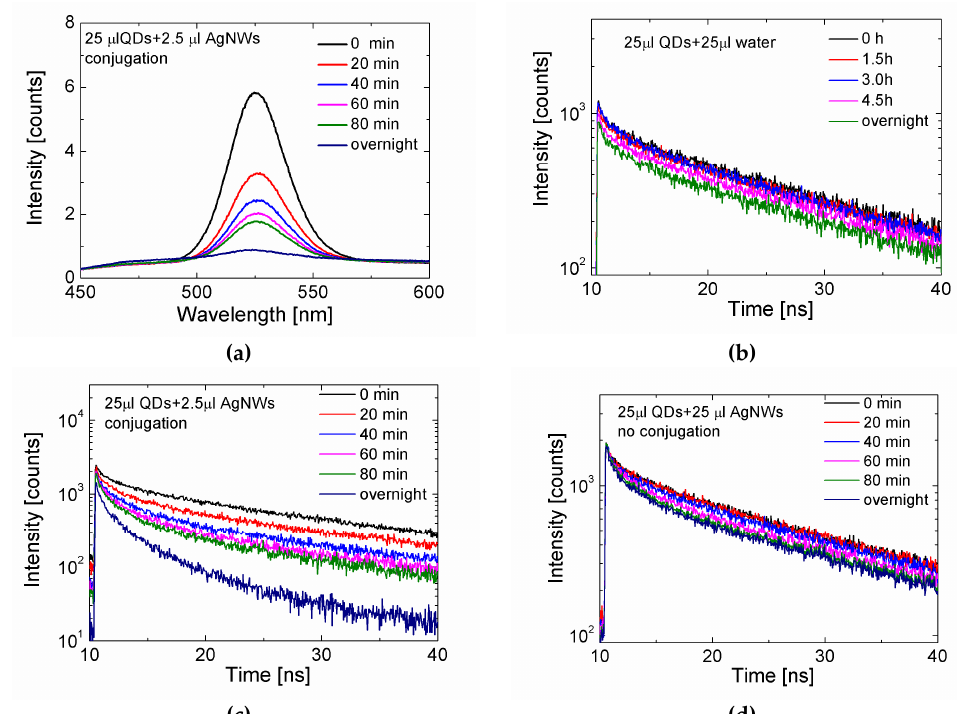
Figure 6. Results of fluorescence spectroscopy of conjugation between CdTe nanocrystals and silver nanowires: evolution of fluorescence spectra ( a ) and fluorescence decay curves for a mixture between the nanocrystals and functionalized nanowires ( c ). Fluorescence transients collected for both solution of nanocrystals-only ( b ) and a mixture of nanocrystals and nanowires without functional groups are shown in the ( d ).